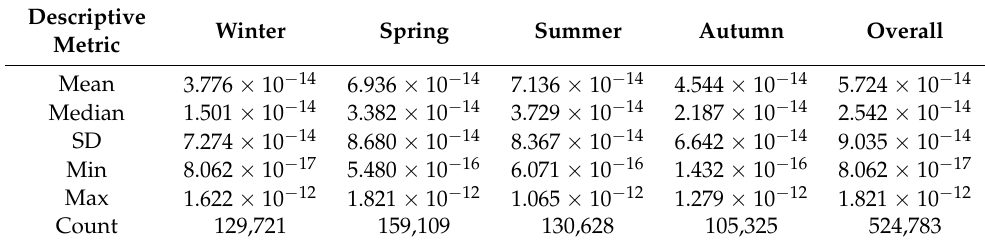
Table 1. Descriptive Statistics for C 2 n